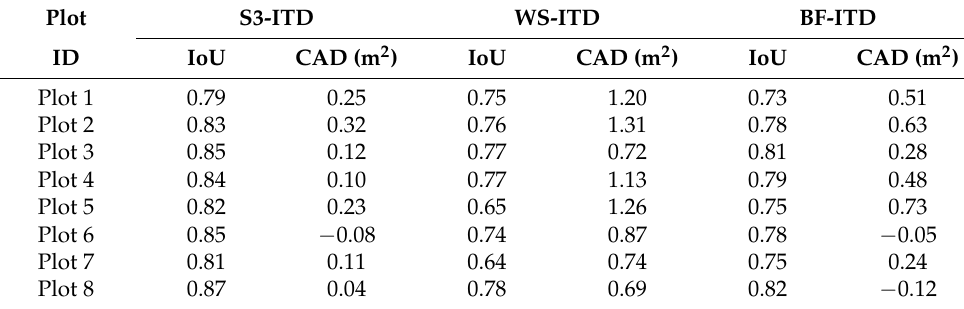
Table 3. The mean intersection over union (IoU) and mean crown-area difference (CAD) for trees in the eight reference plots. For an accurately delineated crown, the IoU ∈ (0, 1) and CAD ∈ ( − ∞ , ∞ ) will be 1 m 2 and 0 m 2 ,